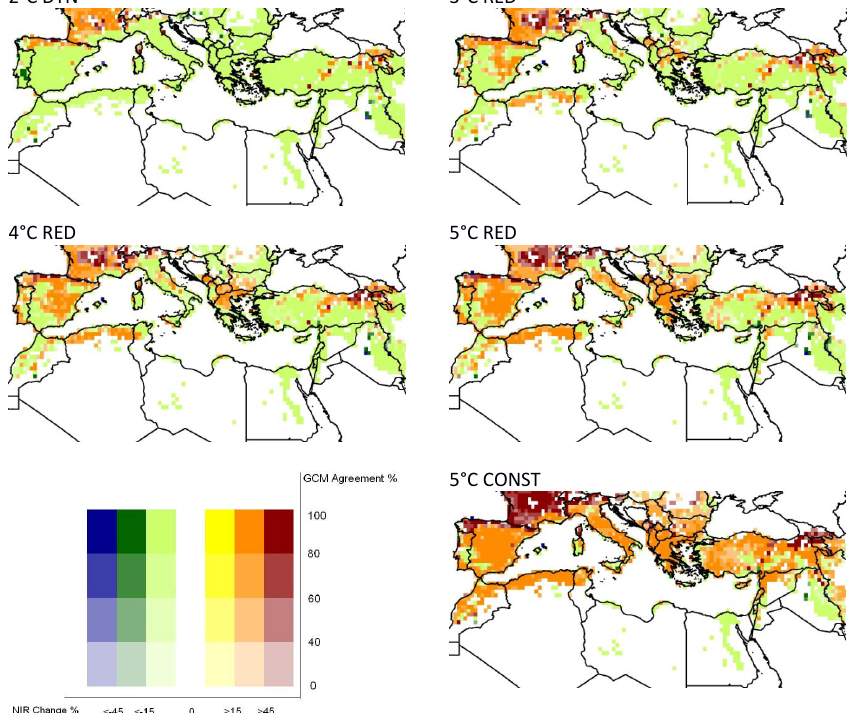
Figure 4. Change in area net irrigation water requirements (NIR) from 2000–2009 to 2080–2090 and GCM agreement (saturation) for 2 to 5 ◦ C warming combined with different CO 2 scenarios. See the Supplement (Fig. S6) for all scenarios arranged according to warming